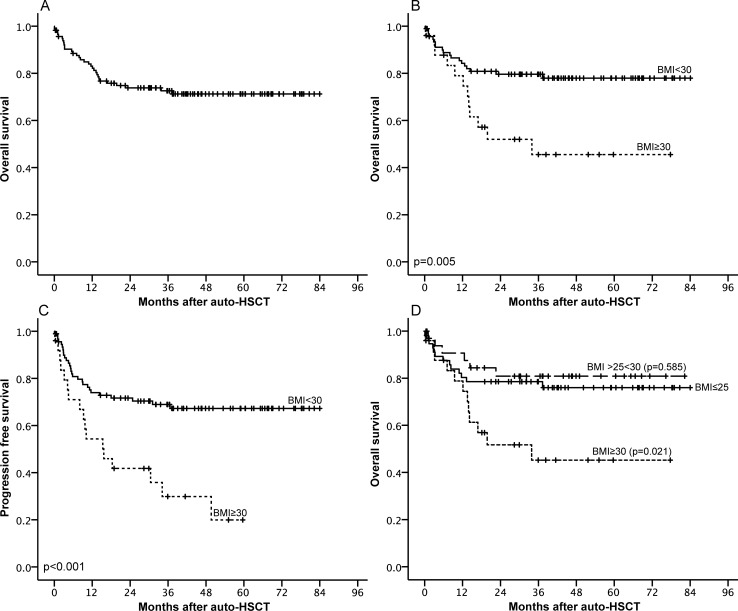
(A) Kaplan-Meier estimates for Overall survival (OS). (B) OS stratified by body mass index (BMI) <30 (solid line) and ≥30 (dotted line). (C) Progression-free survival estimates stratified by BMI < 30 (solid line) and ≥ 30 (dotted line). (D) OS stratified by BMI ≤25 (solid line), >25 and <30 (dashed line) and ≥30 (dotted line), p-values denote differences of each group compared to BMI ≤25.